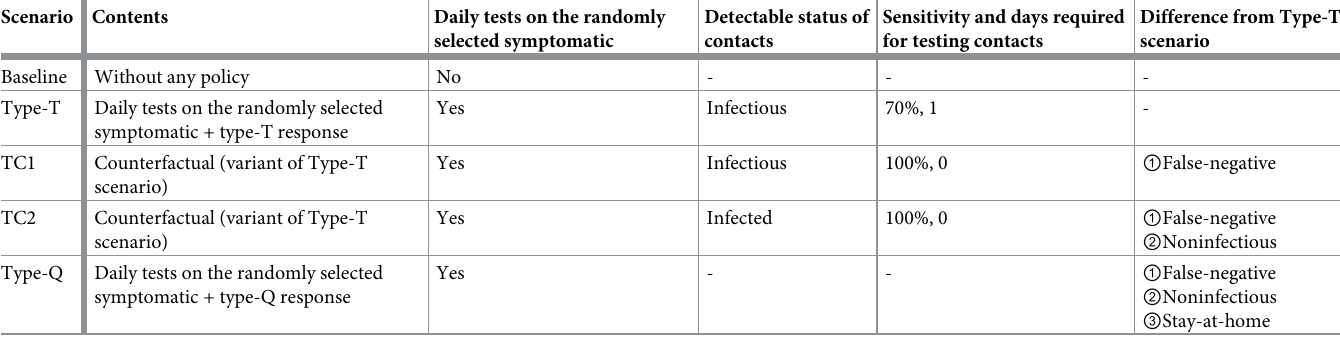
Table 5. Scenarios to identify the main driver of the effectiveness that type-Q response